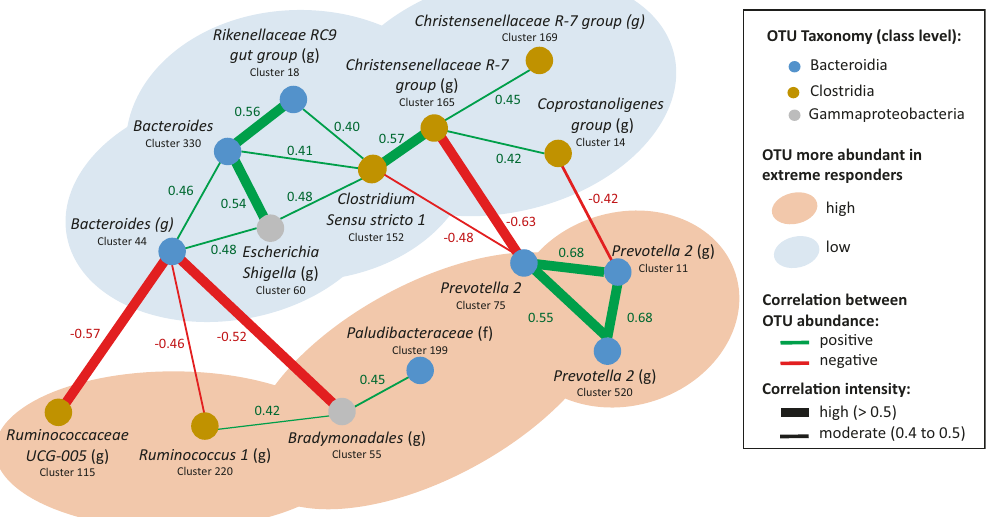
Fig. 5 Co-abundance network of OTUs that were differentially abundant in the D28 fecal microbiota of pigs that demonstrated extreme IAV-speci fi c IgG responses at D63. Only intermediate (fastsparr correlation > 0.4) or high (fastsparr correlation > 0.5) correlations of statistically signi fi cant effect ( p -value < 0.05) are represented, reducing the initial number of 23 differentially abundant OTUs to 15 in the fi gure. OTUs that were more abundant in high or low responders are surrounded by pale orange or pale blue ovoids, respectively. Each OTU is represented by a node with a color that corresponds to its class af fi liation (blue for Bacteroidia, brown for Clostridia, and gray for Gammaproteobacteria). Each OTU is named with its corresponding sequence cluster identi fi er with annotation at the genus (g) or family (f) level. Co-abundance between two OTUs is represented by a connecting line, green or red for positive and negative correlations, respectively. The thickness of the connecting lines is proportional to the strength of the correlation, either between 0.4 and 0.5 or above 0.5. Correlation was calculated on the whole population of 89 vaccinated piglets and their associated p-values are available in Supplementary Data